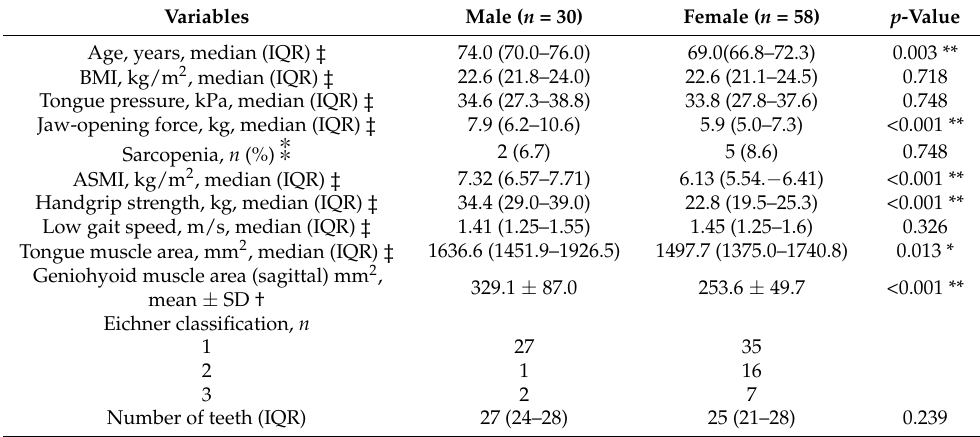
Table 2. Comparisons of characteristics of men and women. Table 3. Comparisons of characteristics between sarcopenia and non-sarcopenia groups.